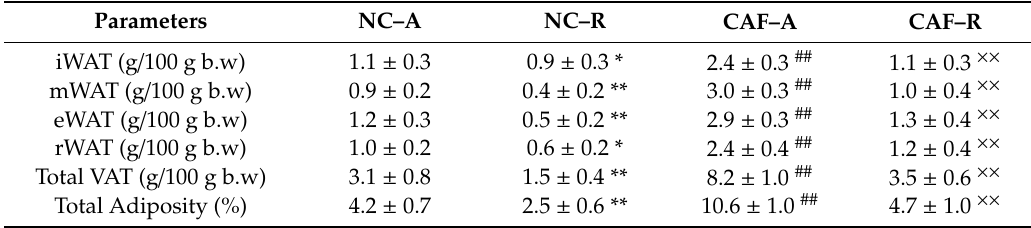
Table 1. E ff ects of time-restricted feeding on relative white fat pads weightand total adiposity. Parameters NC–A iWAT (g / 100 g b.w)